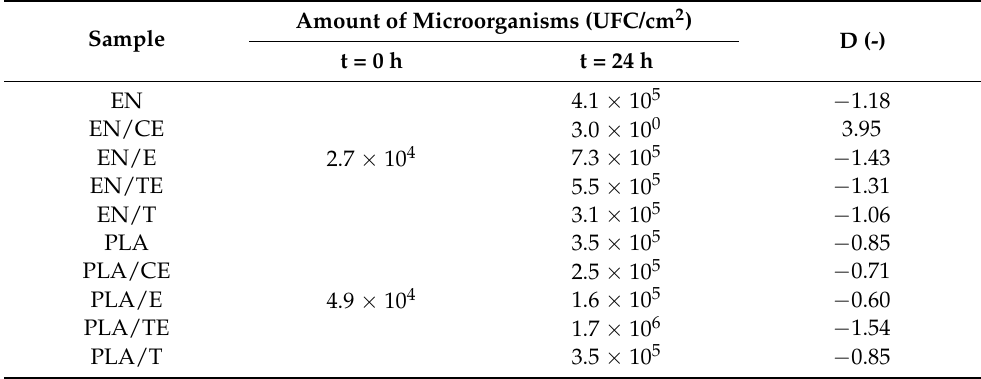
Table 5. Results of antimicrobial tests performed for unimpregnated and impregnated polymer specimens: UFC—unit-forming